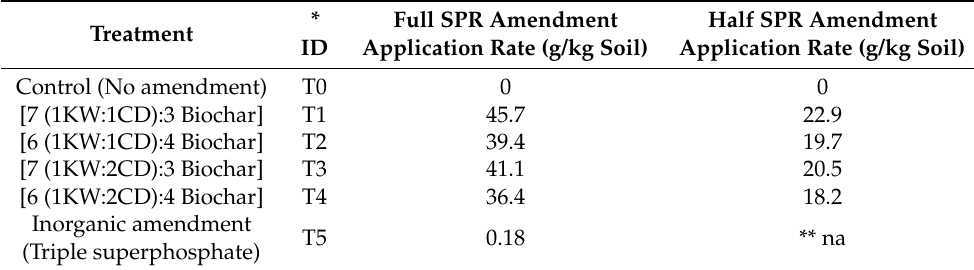
Table 2. Rates of amendments to meet the standard phosphorus requirement (SPR) and half SPR of the soil.